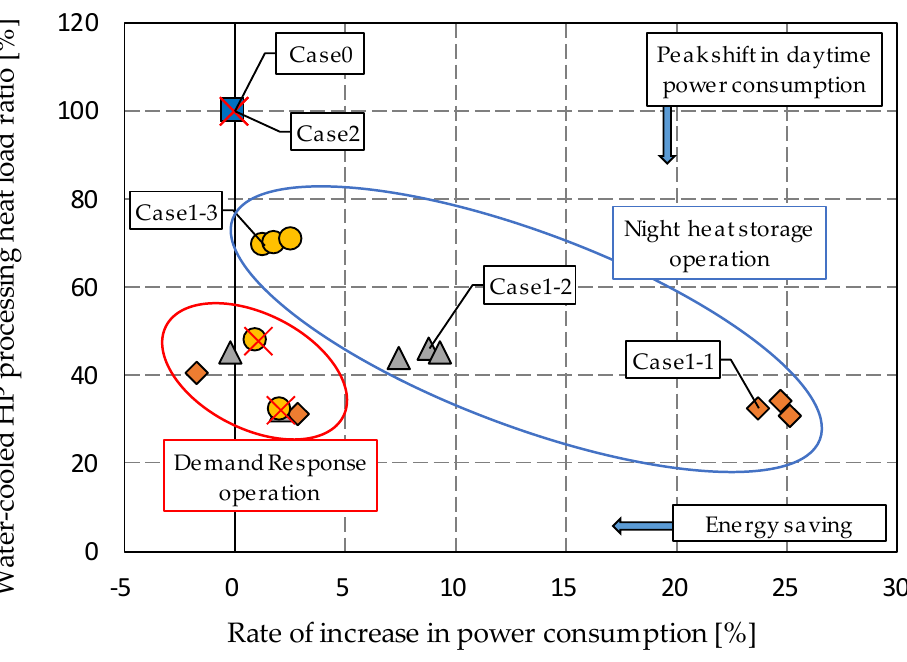
Figure 14. Water-cooled HP processing heat load ratio and rate of increase in power consumption.